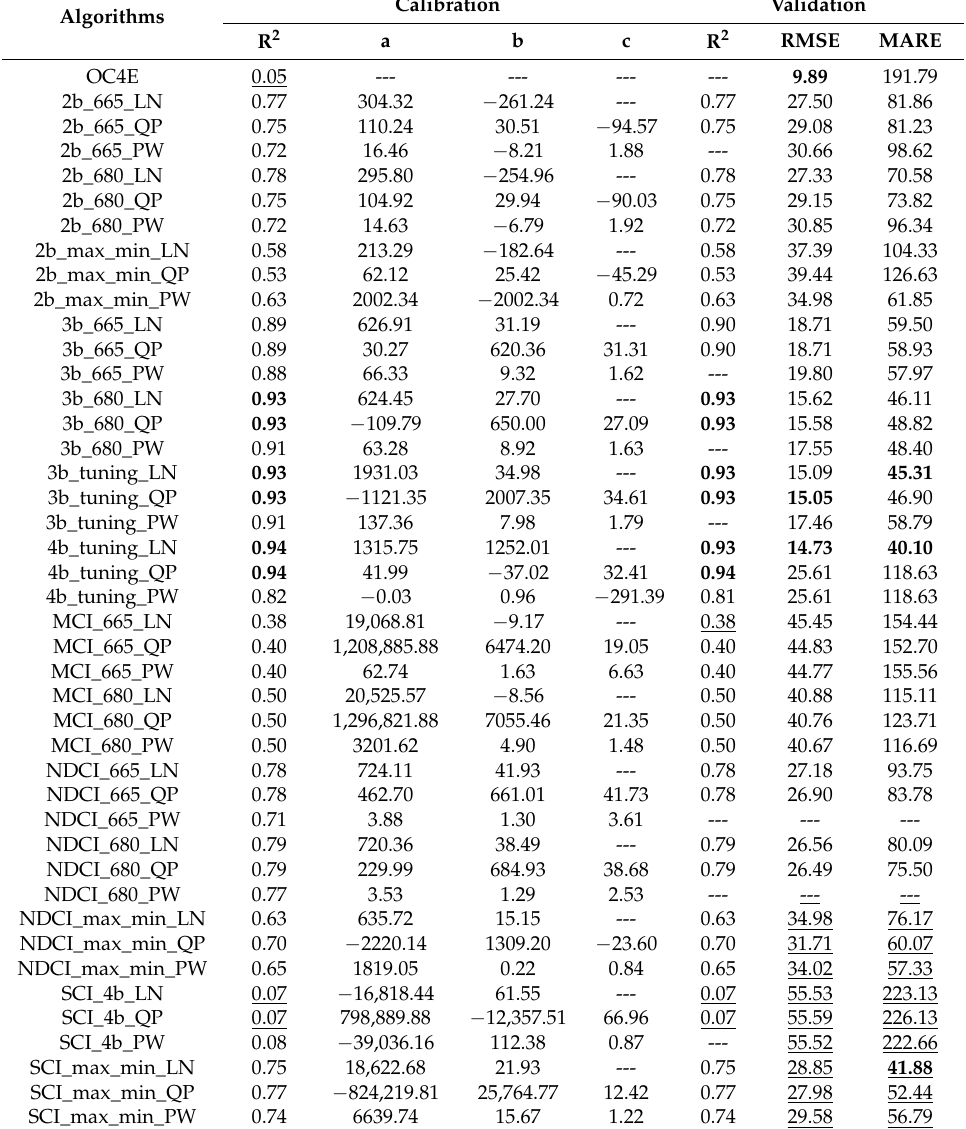
Table 4. Algorithms’ evaluation during the calibrations and validation stages of simulated